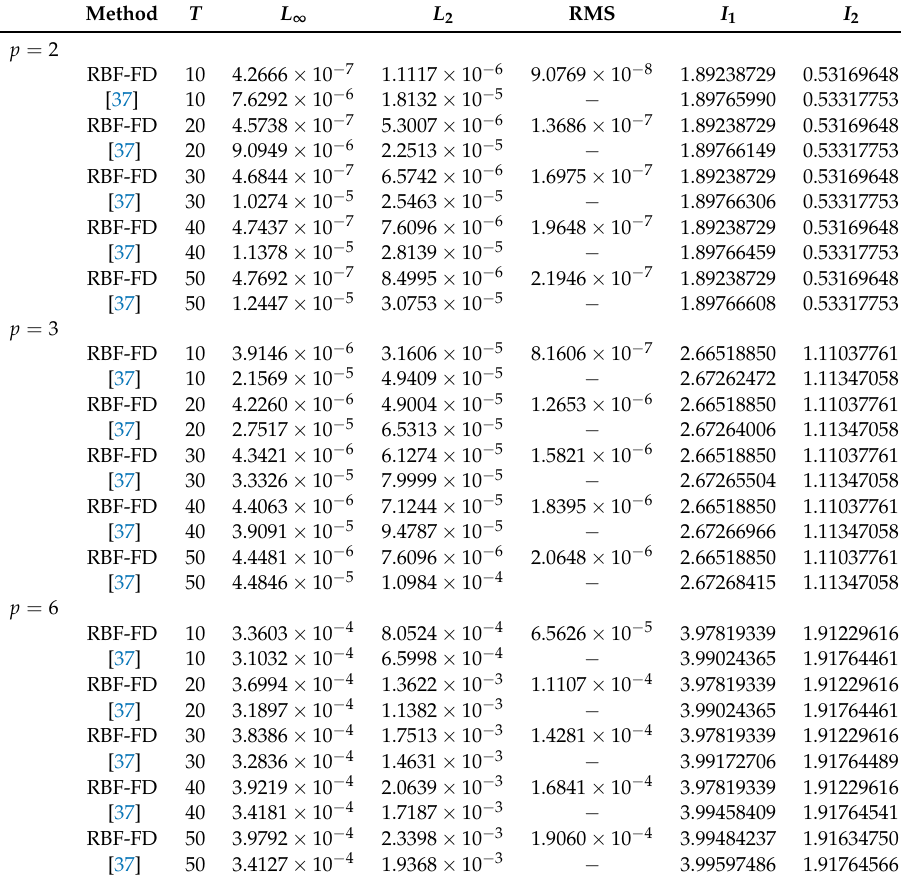
Table 8. The L ∞ , L 2 and RMS errors and the invariants I 1 and I 2 with N = 1500, n i = 1089, c = 2.6 and τ = 0.01 in the spatial interval x ∈ [ − 30,120 ] for Example